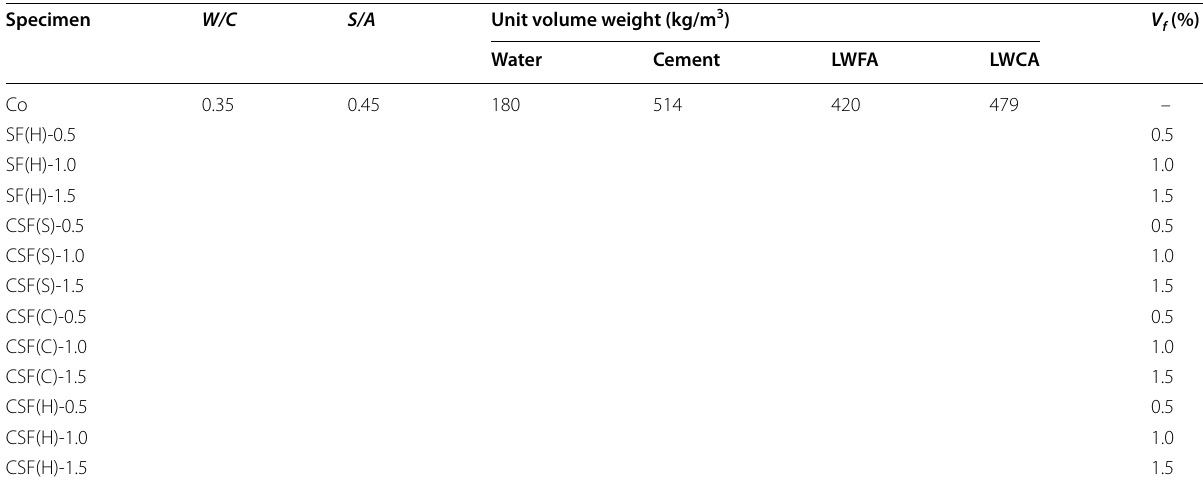
Table 3 Mix proportion of concrete.